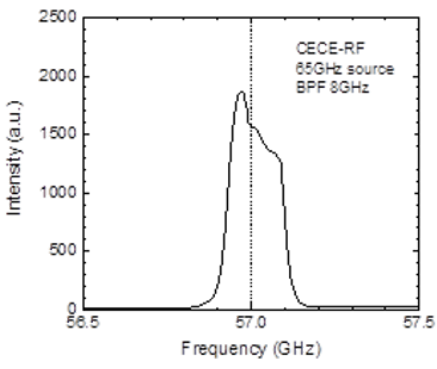
Fig. 4. Frequency conversion and bandwidth of the CECE-RF channel of the CECE radiometer. The LO was scanned to measure the CECE-RF response to a 65 GHz Gunn oscillator. The intermediate frequency bandwidth and relative sensitivity of the CECE-IF channels was measured by applying an RF source (2-20 GHz) to the IF line of each channel. As shown in Figure 5, the measured bandwidth of each channel is between 0.1 and 0.2 GHz and the sensitivity of the radiometer decreases with higher IF frequency. Post-detection amplification is used to increase the signal measured at higher frequencies.